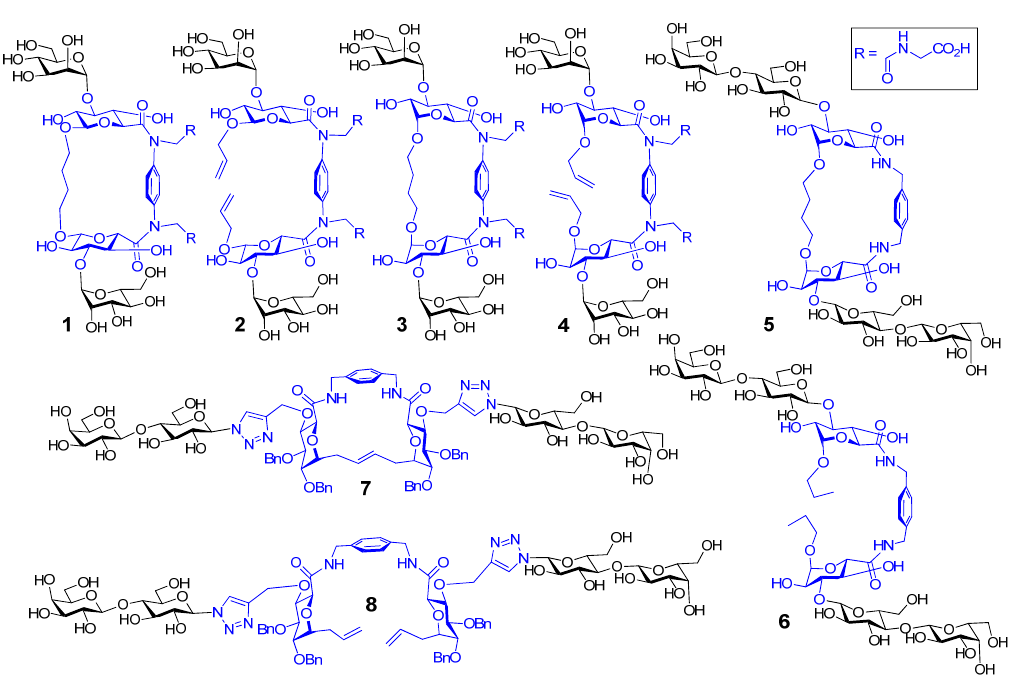
Figure 4. Structures of macrocyclic glycophane scaffolds (blue) with mannose ( 1 , 3 ) or with lactose ( 5 , 7 ) and their acyclic analogues ( 2 , 4 , 6 , 8